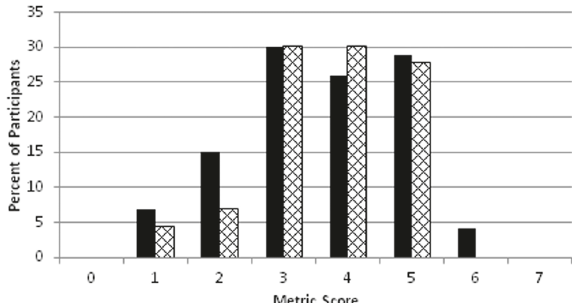
Figure2: F r equencydist r ibutionofmet r icsco r es. Blackbarsshow the metric score frequency distributions for 6-metric scores (n=73) based on one point each for non-HDL-C, BMI, BP, exercise, diet, and smoking. Hatched bars show the 7-metric score distribution for participants who had a HbA1c done based on the presence of diabetes or obesity